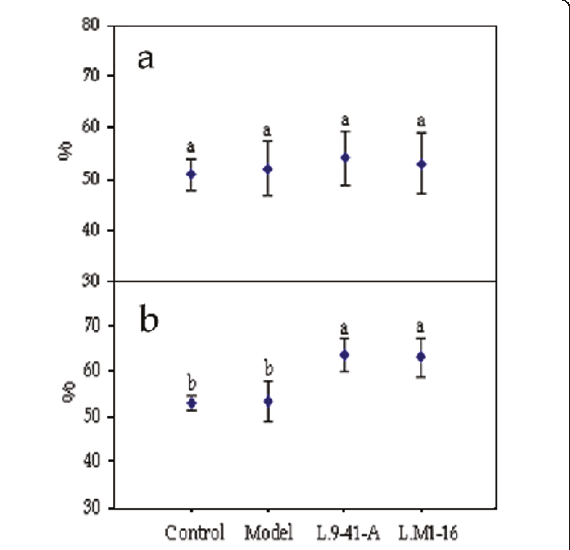
Figure 5 Fecal water content from the rats in the four groups . Control group: nomal diet; model group:high-cholesterol diet; L .9- 41-A group:high-cholesterol diet + L. plantarum 9-41-A; L.M1 -16 group:high-cholesterol diet + L. fermentum M1-16. a:Water content on the middleday of the third week. b:Water content on the middleday of the sixth week. a,b Mean values with different superscript letters differ significantly (p <